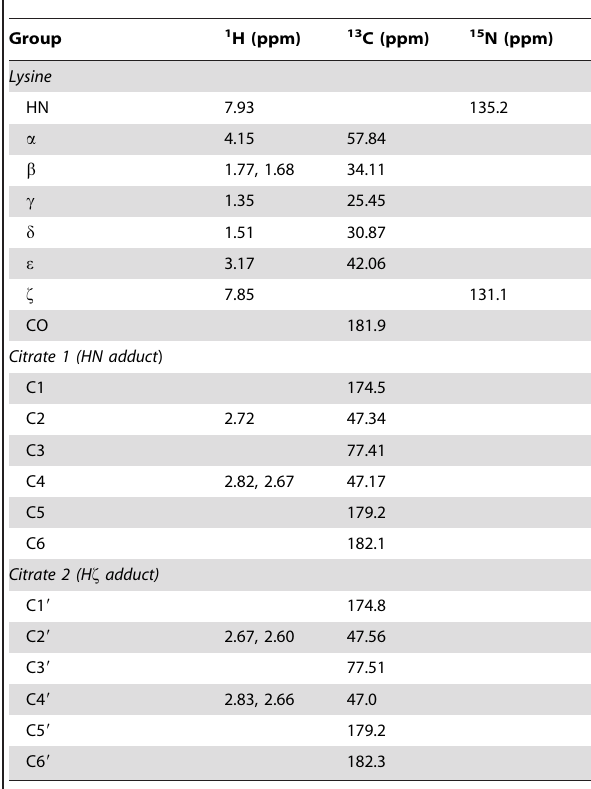
Table 1. List of Chemical Shifts for Corynebactin.